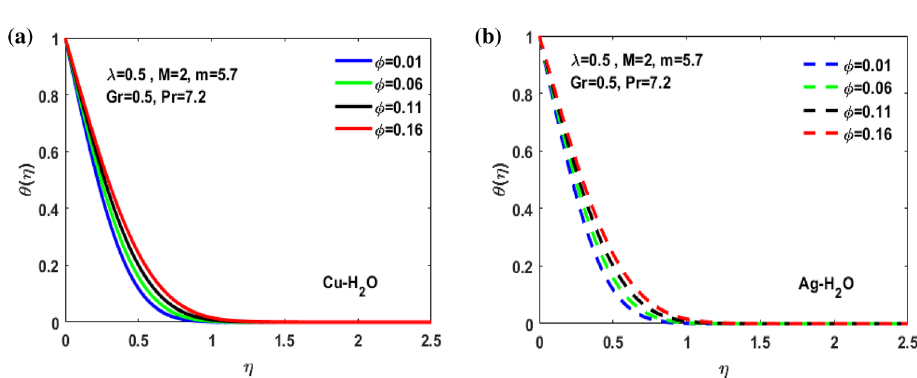
Figure 8. ( a ) Effect of (cid:31) on θ(η) . ( b ) Effect of (cid:31) on θ(η)